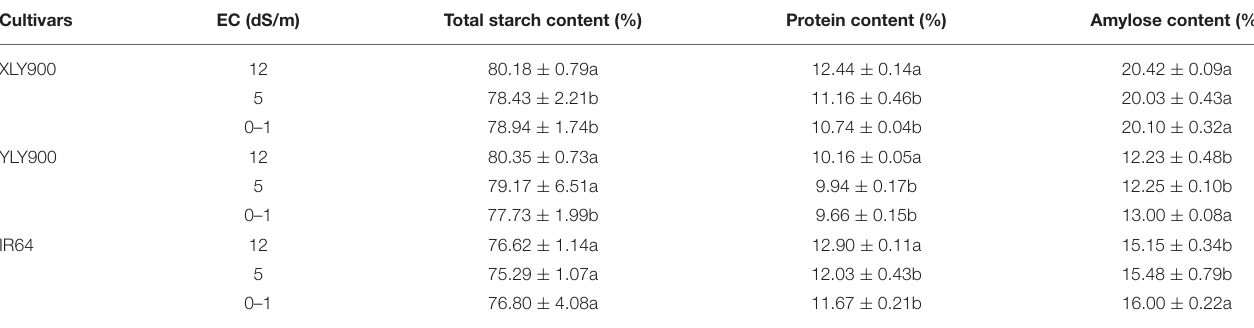
TABLE 1 | Effects of salt stress on the chemical composition of polished rice. Cultivars